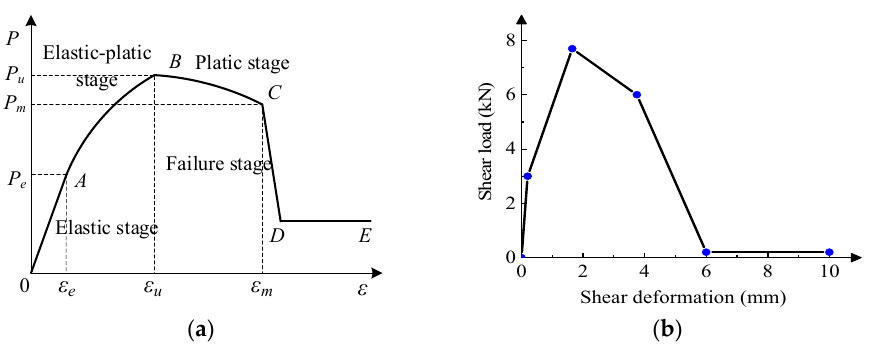
Figure 10. The constitutive model of the shear behavior of the SPR connection in the FEA: ( a ) sim- plified principle of the SPR connection, ( b ) constitutive model of the link element.